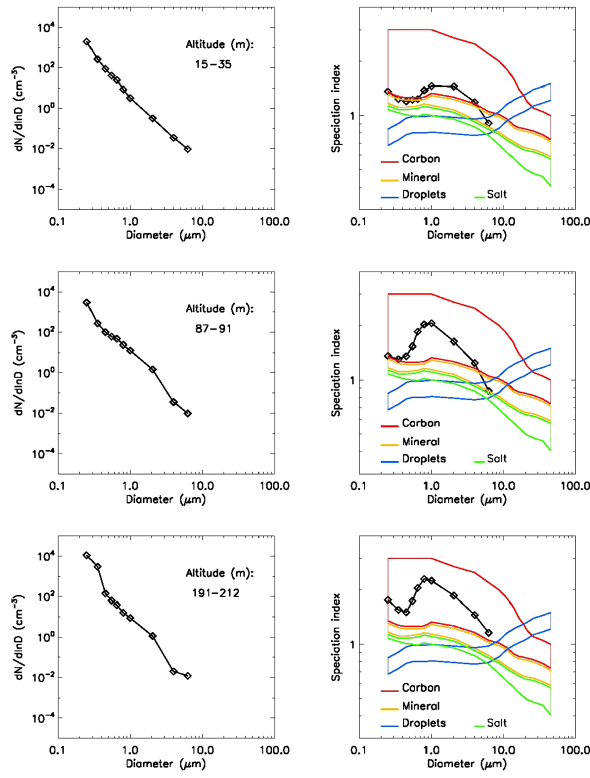
Figure 8. Evolution of the concentrations for the 19 size classes of LOAC, during a flight under the OAG tethered balloon in Paris (France); top: on 10 April 2014 at 9:15UT (low level of pollution); bottom: on 11 December 2013 at 10:15UT with a high level of fine particles pollution and an accumulation layer at an altitude of 200m; the uncertainty (at 1 σ ) is of about ± 20% for concentrations higher than 10 − 1 cm − 3 up to ± 60% for concentrations lower than 10 − 2 cm − 3 .